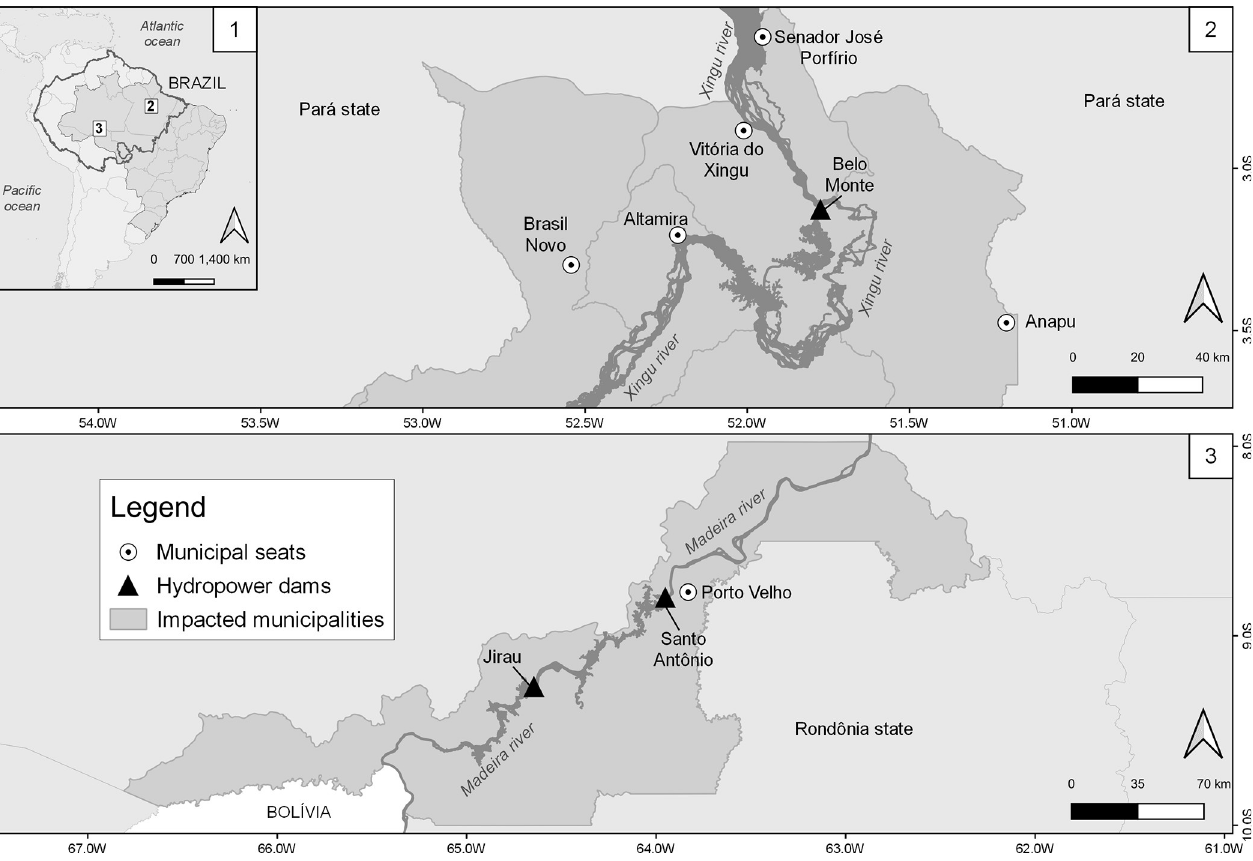
Fig 1. Location of the study sites, the municipalities of Porto Velho, in the Madeira river basin, Rondoˆnia state; and Altamira, Anapu, Brasil Novo, Senador Jose´ Porfı´rio and Vito´ria do Xingu, in the Xingu river basin, Para´ state, Brazil. 1: South America, Brazilian Federal Units and the Amazon basin (continuous line crossing international borders); 2: Altamira and neighboring municipalities (ATM) impacted by Belo Monte dam; 3: Porto Velho municipality (PVH), impacted by Santo Antoˆnio and Jirau dams. Darker gray areas represent the municipalities impacted by dams’ construction. The triangles show the dams’ location, and the darkest grey thick lines represent the rivers. Municipal seats are represented with white circles. Figure created with QGIS software version 3.14, an open source Geographic Information System (GIS) licensed under the GNU General Public License (https://bit.ly/2BSPB2F). Base layer sources: South America shape file retrieved from the Database of Global Administrative Areas (GADM) website (https://bit.ly/3ZqwJ4u), under an open license (CC-BY): http://bit.ly/3Zl2rjE; shape file representing the Brazilian administrative areas provided from the Brazilian Institute of Geography and Statistics (IBGE) website (https://bit.ly/3vWaZjC), under an open license (CC-BY): https://bit.ly/3W2qxNk.